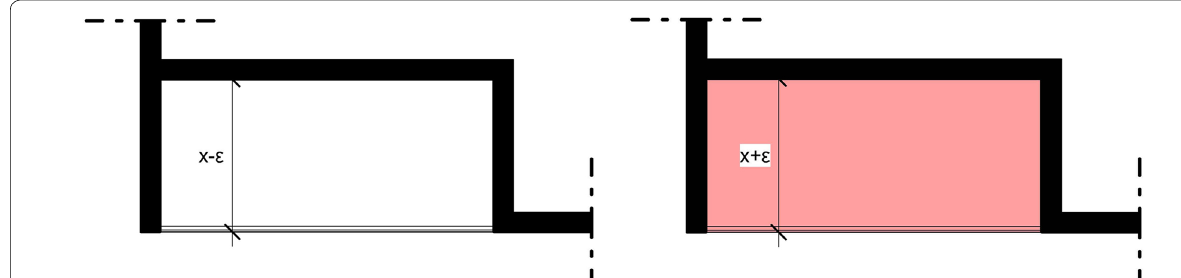
Fig. 3 Loggias inside and outside the “x” value